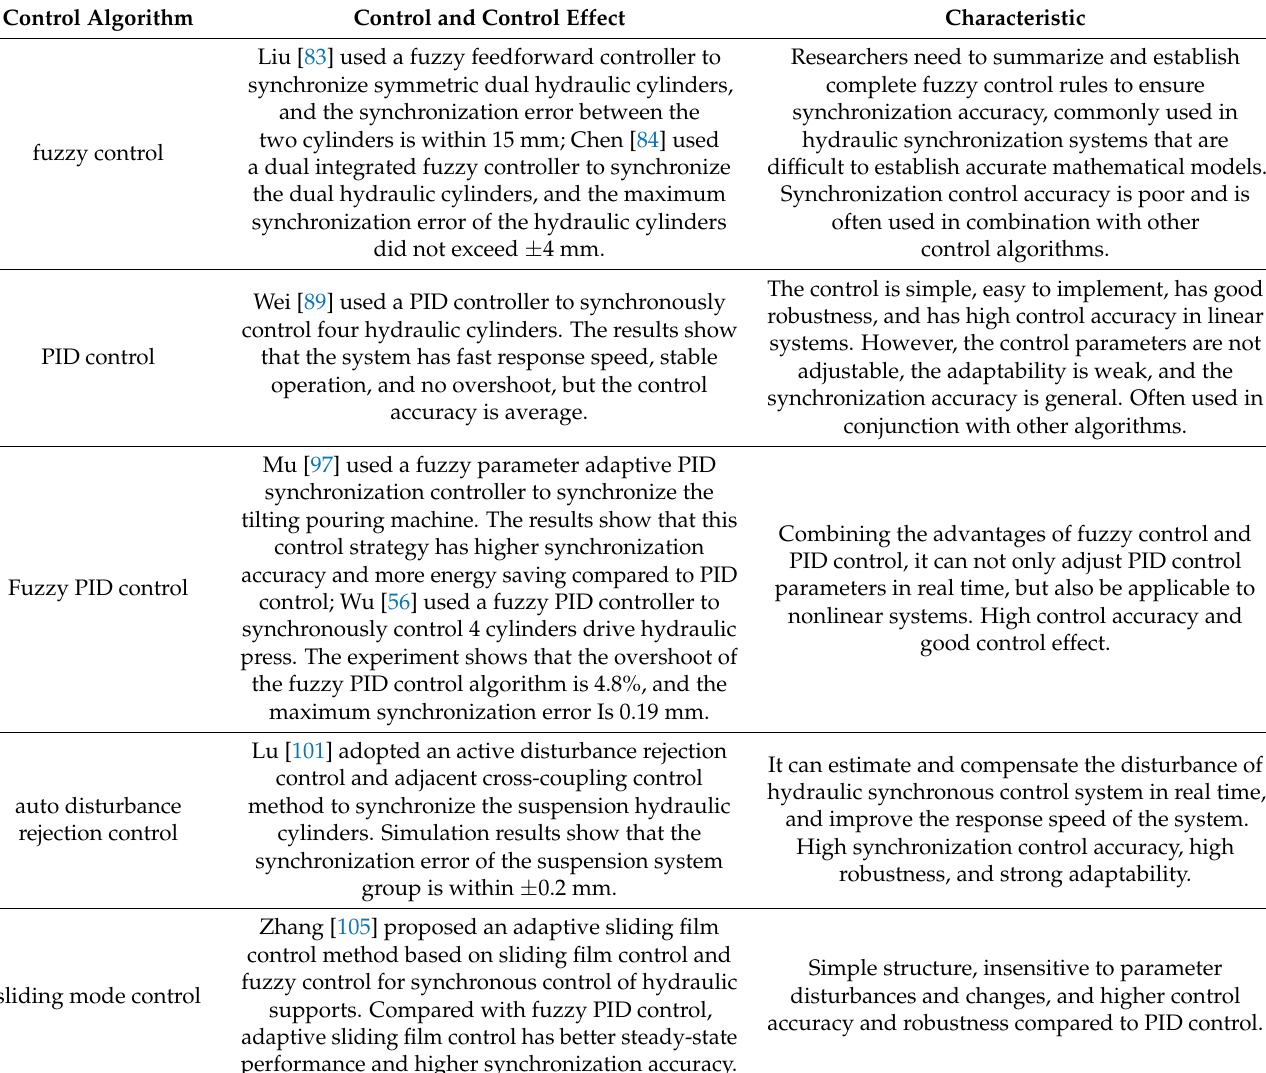
Table 2. Comparison of Different Control Algorithms for Hydraulic Synchronization